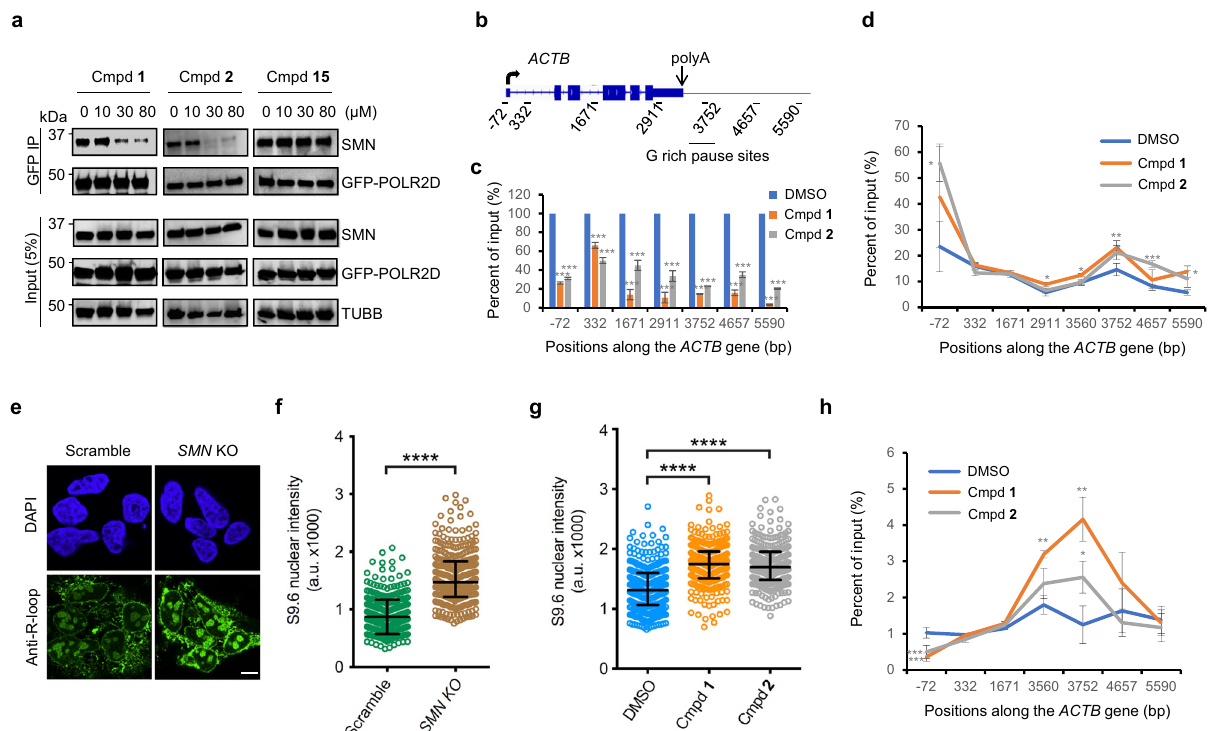
g SMN antagonists cause global nuclear R-loop accumulation. h SMN antagonists lead to R-loop accumulation at ACTB gene locus. Quanti fi ed DNA immunoprecipi- tation using primers along ACTB locus by using GFP antibody, in cell extracts that were transfected with GFP-RNase H1 R-loop-binding domain (GFP-HB) fusion con- struct for R-loop detection. a – h HEK293 cells; c , d , h data were presented as the mean ± S.E.M. of three independent experiments (* P <0.05, ** P <0.01, *** P <0.001 for the two-tailed Student ’ s t -test); f , g scatter plots representing data from single- celland R-loop immuno fl uorescence analysis (number of cells= 377, 332,295,262, 265forscramble, SMN KO,DMSO,Cmpd 1 ,Cmpd 2 condition,respectively;Mean± Quartiles;**** P <0.0001forthetwo-tailedMann – Whitneytest;a.u.:arbitraryunits). Source data are provided as a Source Data fi